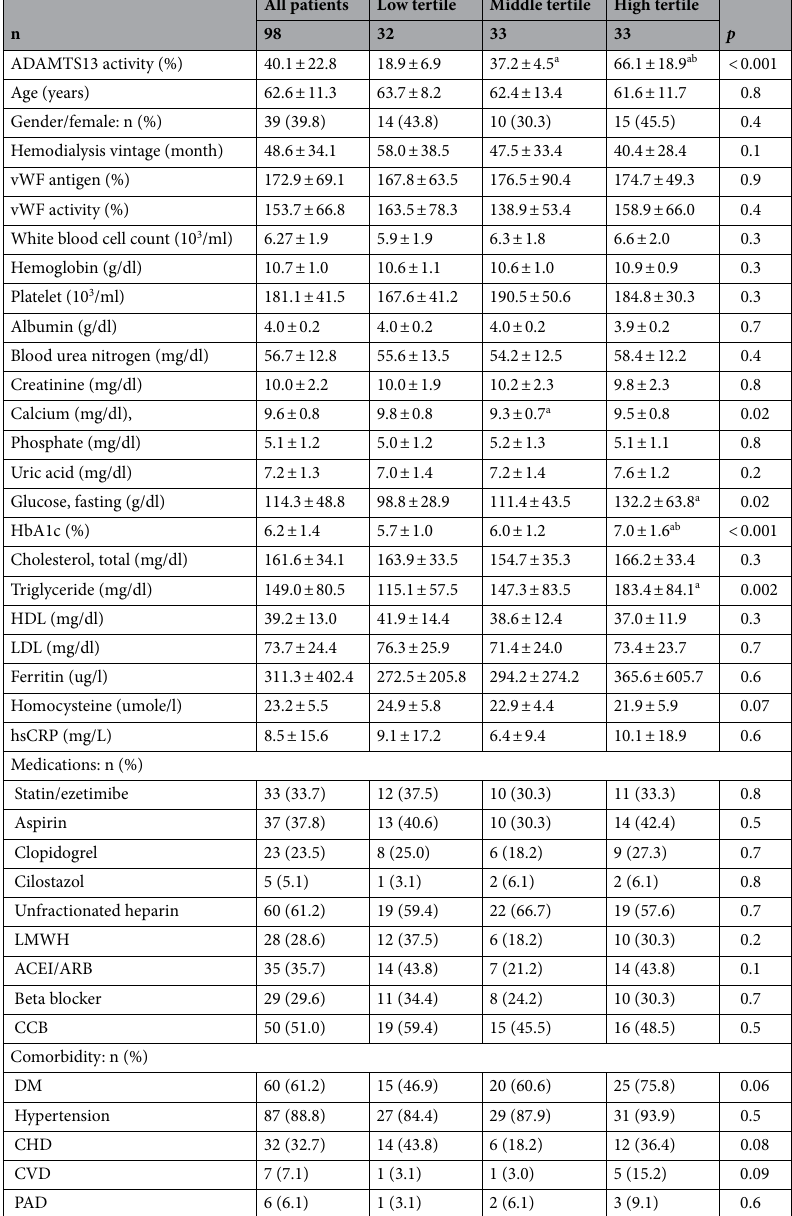
Table 1. Demographic and laboratory data of 98 chronic hemodialysis patients and the comparisons among three tertile groups according to ADAMTS13 activity. vWF = von Willebrand factor, HbA1c = hemoglobin A1c, HDL = high-density lipoprotein cholesterol, LDL = low-density lipoprotein cholesterol, hsCRP = high sensitivity C-reactive protein, LMWH = low molecular weight heparin, ACEI/ARB = angiotensin-converting enzyme inhibitor/angiotensin II receptor blocker, CCB = calcium-channel blocker, DM = diabetes mellitus, CHD = coronary heart disease, CVD = cerebral vascular disease, PAD = peripheral artery disease. a p < 0.05 versus low tertile, b p < 0.05 versus middle tertile (Post Hoc analysis using Scheffe